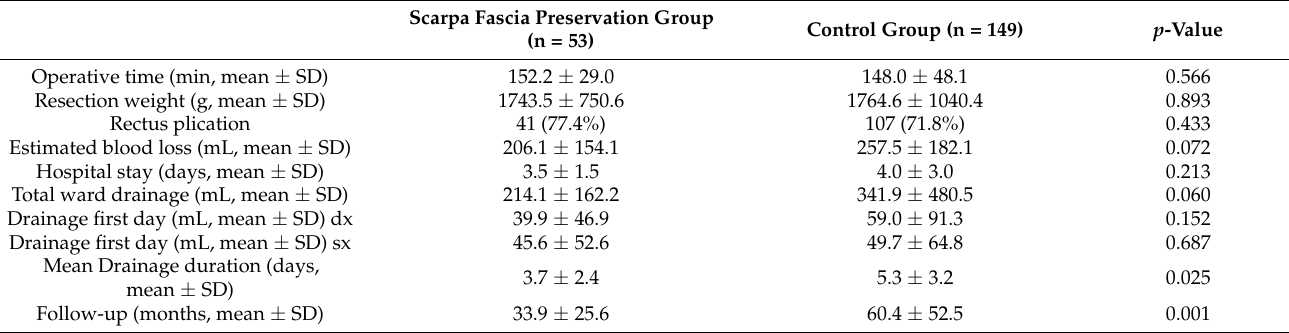
Table 2. Comparison of peri-operative parameters in the two groups of patients.